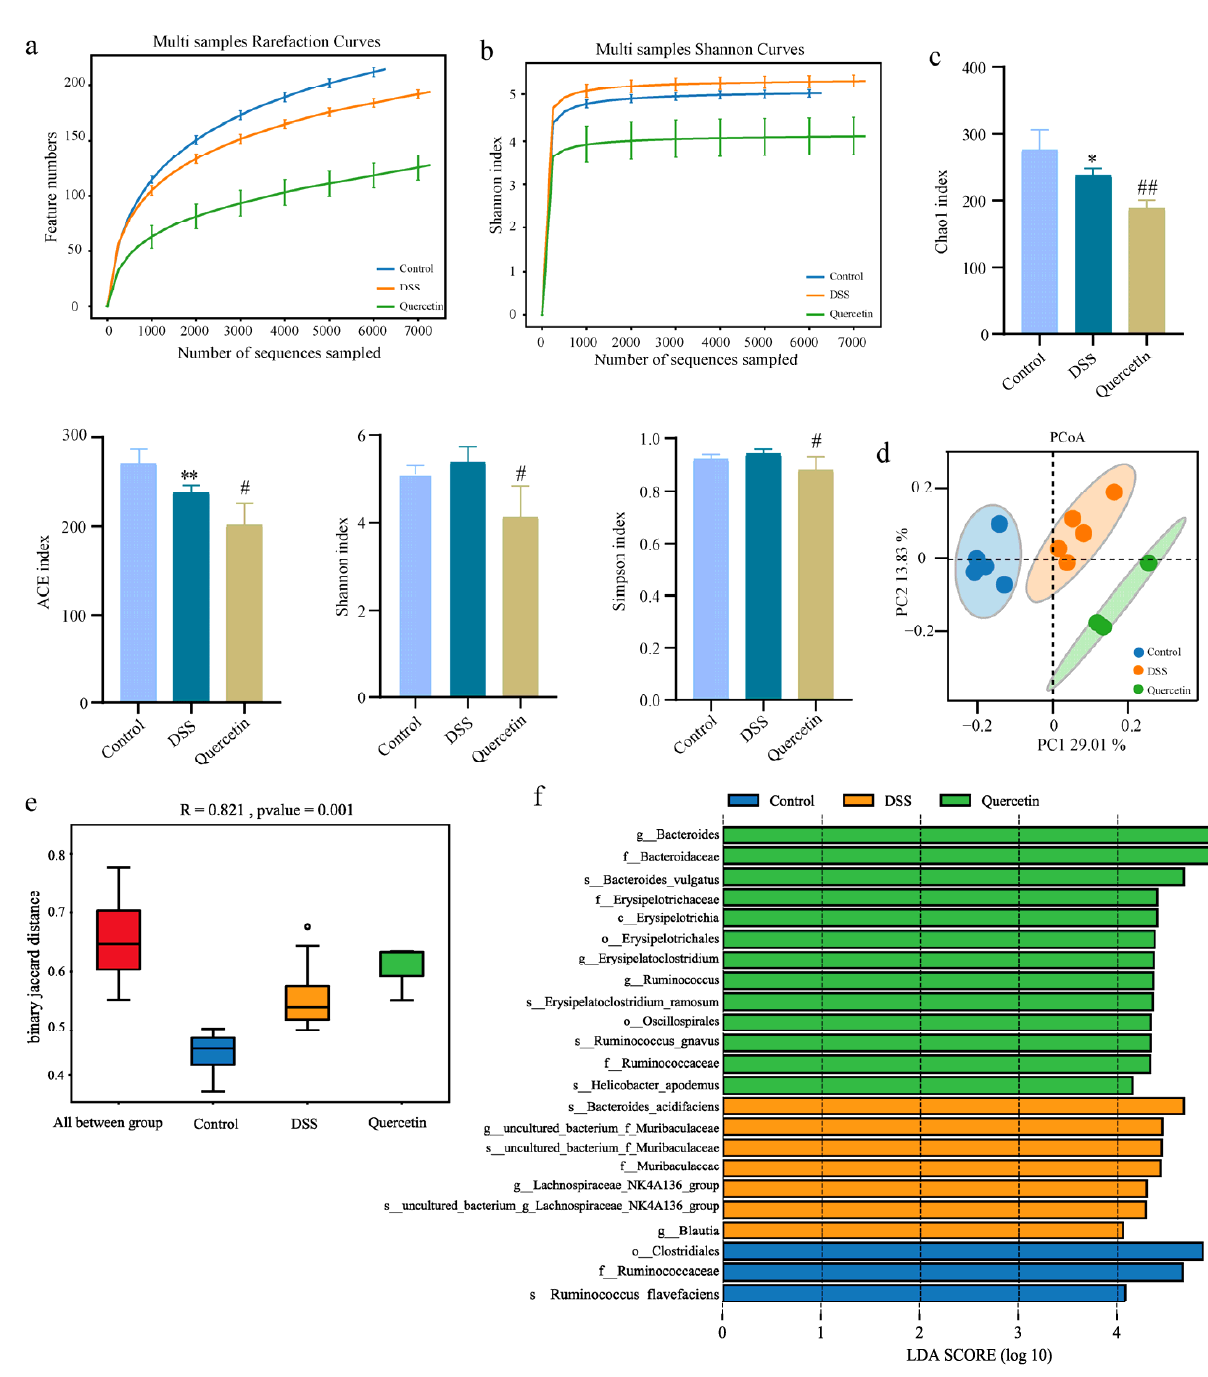
Figure 5. Alteration in microbiota profile in different groups. ( a ) Rarefaction analysis. ( b ) Shannon index curves. ( c ) Alpha-diversity index of microbial communities in mice treated with DSS or quercetin. * p < 0.05, ** p < 0.01 compared with the control group; # p < 0.05, ## p < 0.01 compared with the DSS group. ( d ) PCoA plot of unweighted unifrac distance. ( e ) Anosim analysis of intestinal bacterial community in mice. ( f ) LEfSe